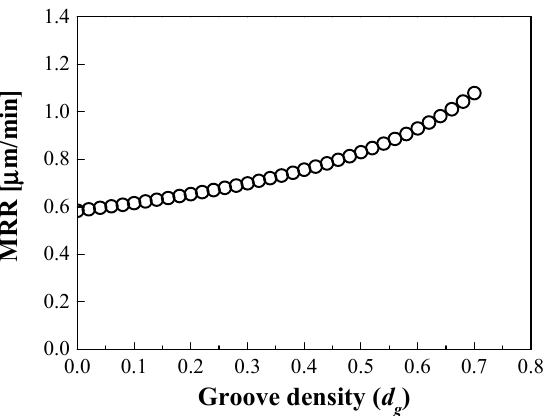
Figure 5. Theoretical material removal rate as a function of groove density.